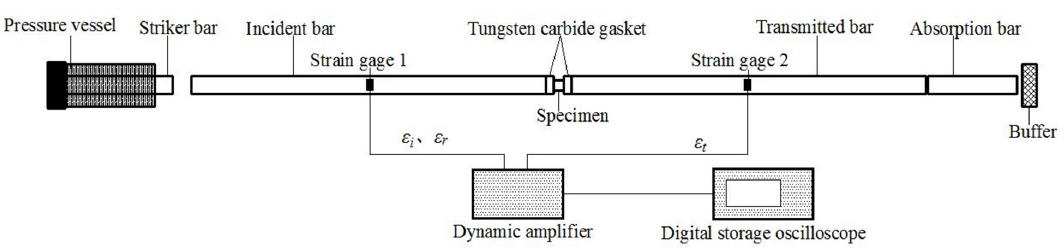
Figure 1. Schematic of the SHPB test.